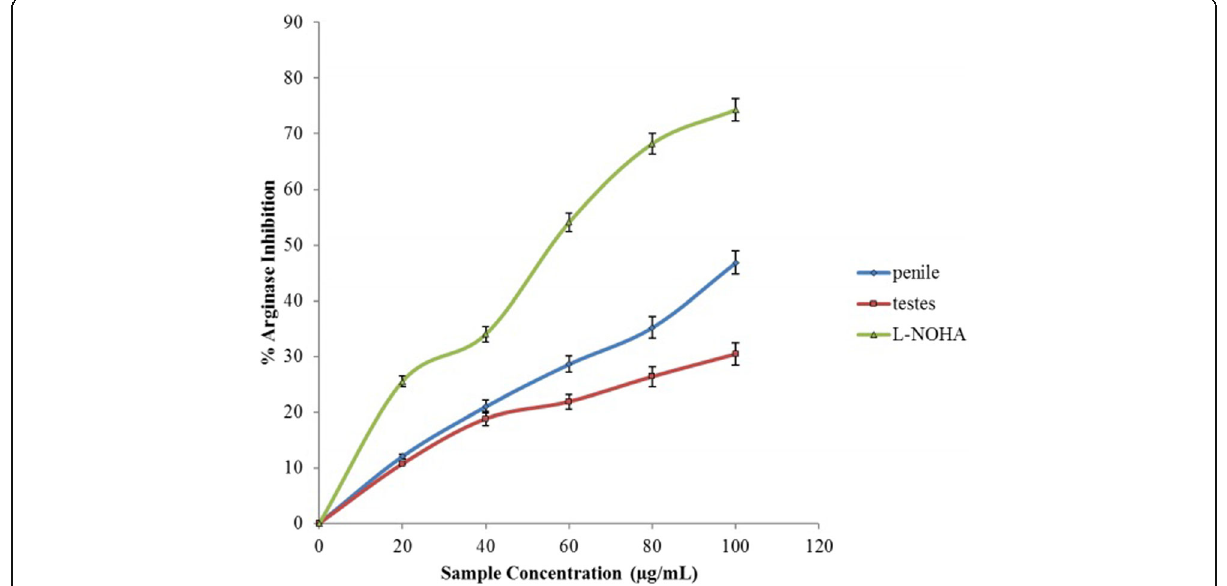
Fig. 2 Inhibition of Arginase activity in rats ’ genitals by aqueous extract from Ocimum gratissimum